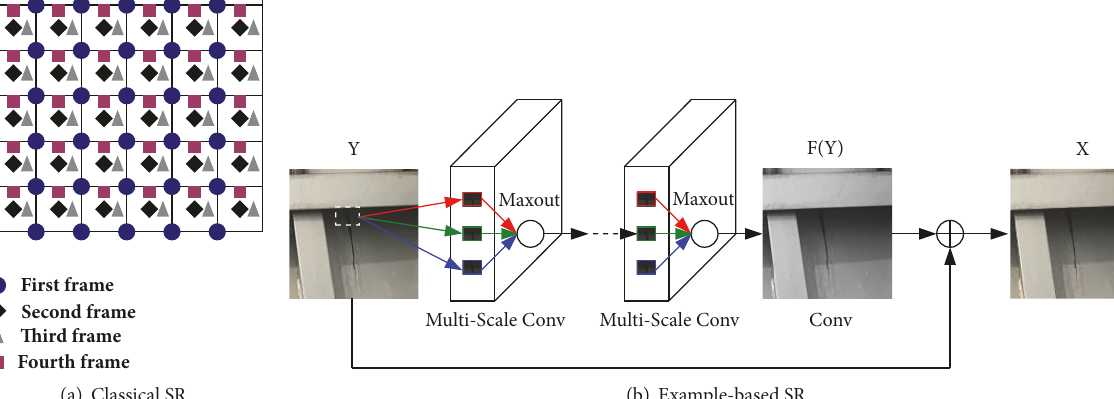
Figure 2: The relation of LR samples mapped on HR grid.